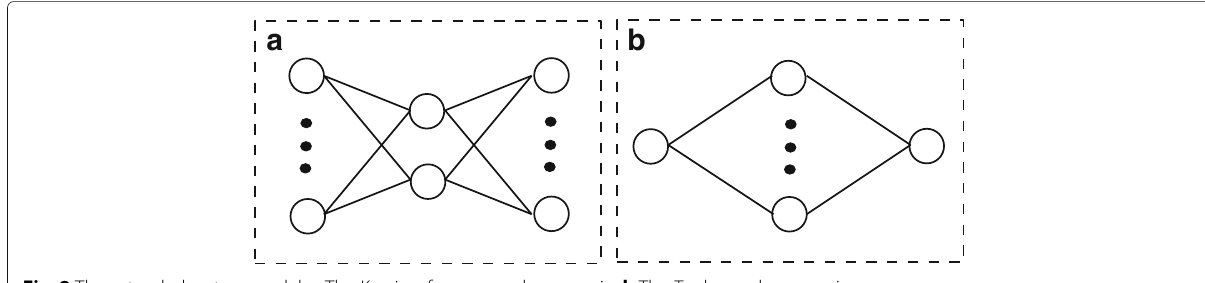
It is clear that the derivative of (31) is quite involved. We turn to an approximation of it for the higher SNRs. With